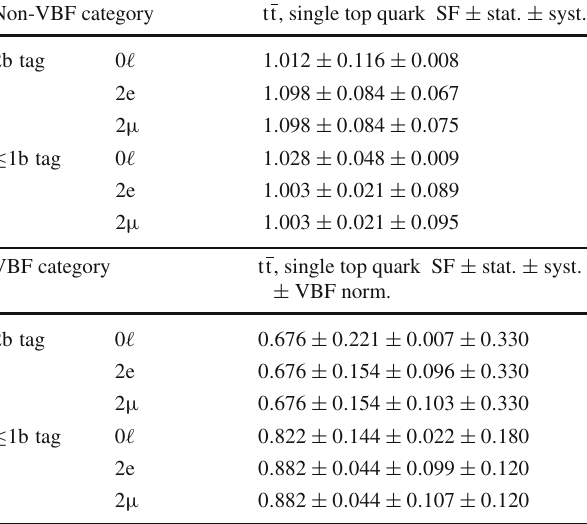
Table 2 Scale factors derived for the normalization of the tt and single top quark backgrounds for different event categories. Uncertainties due to the limited size of the event samples (stat.) and systematic effects (syst.)arereportedaswell.Thescalefactorsofthe2e and2 μ categories are derived using the 1e1 μ top quark control region as described in